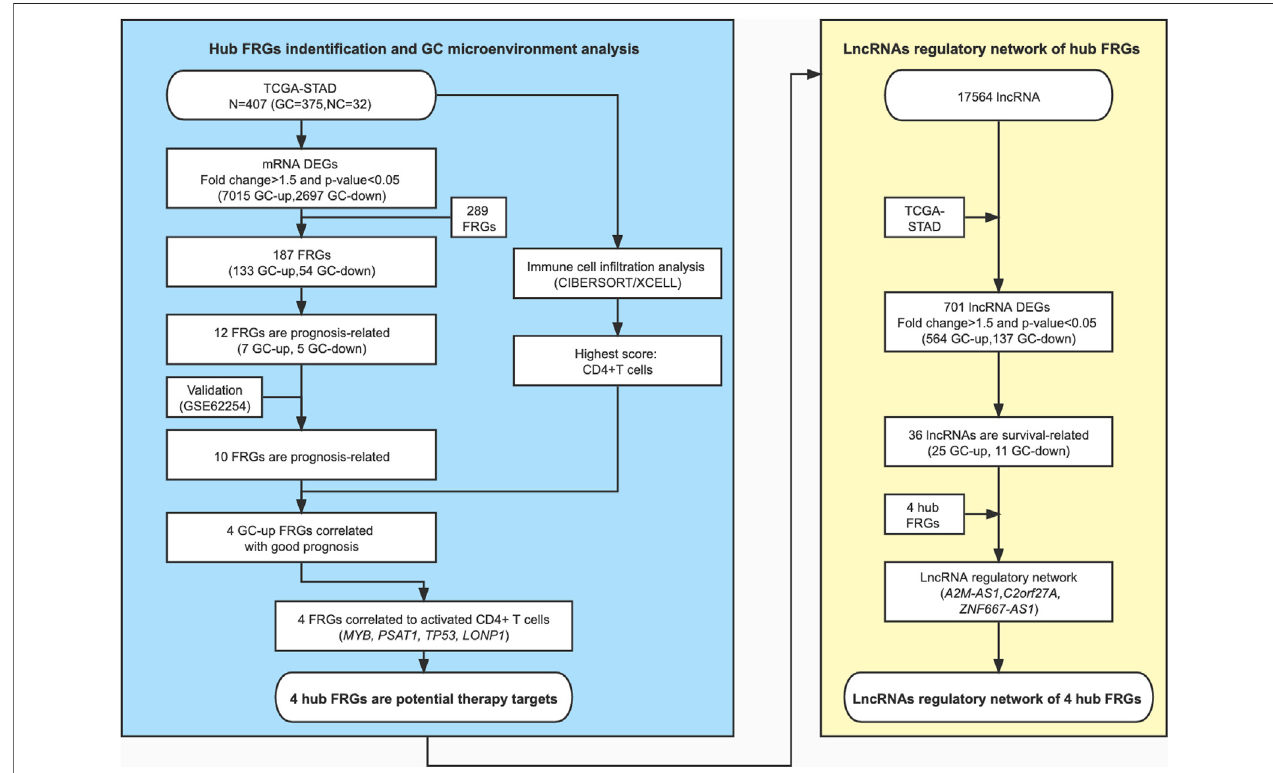
FIGURE 1 | A schematic diagram of the study design and patient cohorts for the identi fi cation of hub ferroptosis-related genes.